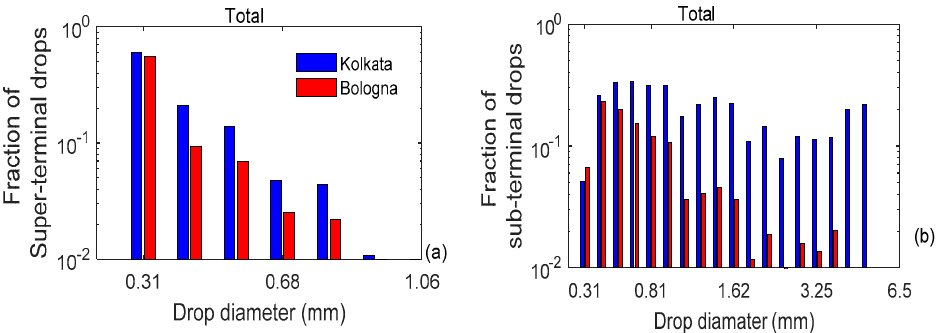
Figure 4. Fraction of ( a ) the super- and ( b ) sub-terminal drops in the natural rain of Kolkata and Bologna. The fraction of sub- and super-terminal drops represents the ratio between these drops and the total number of drops.